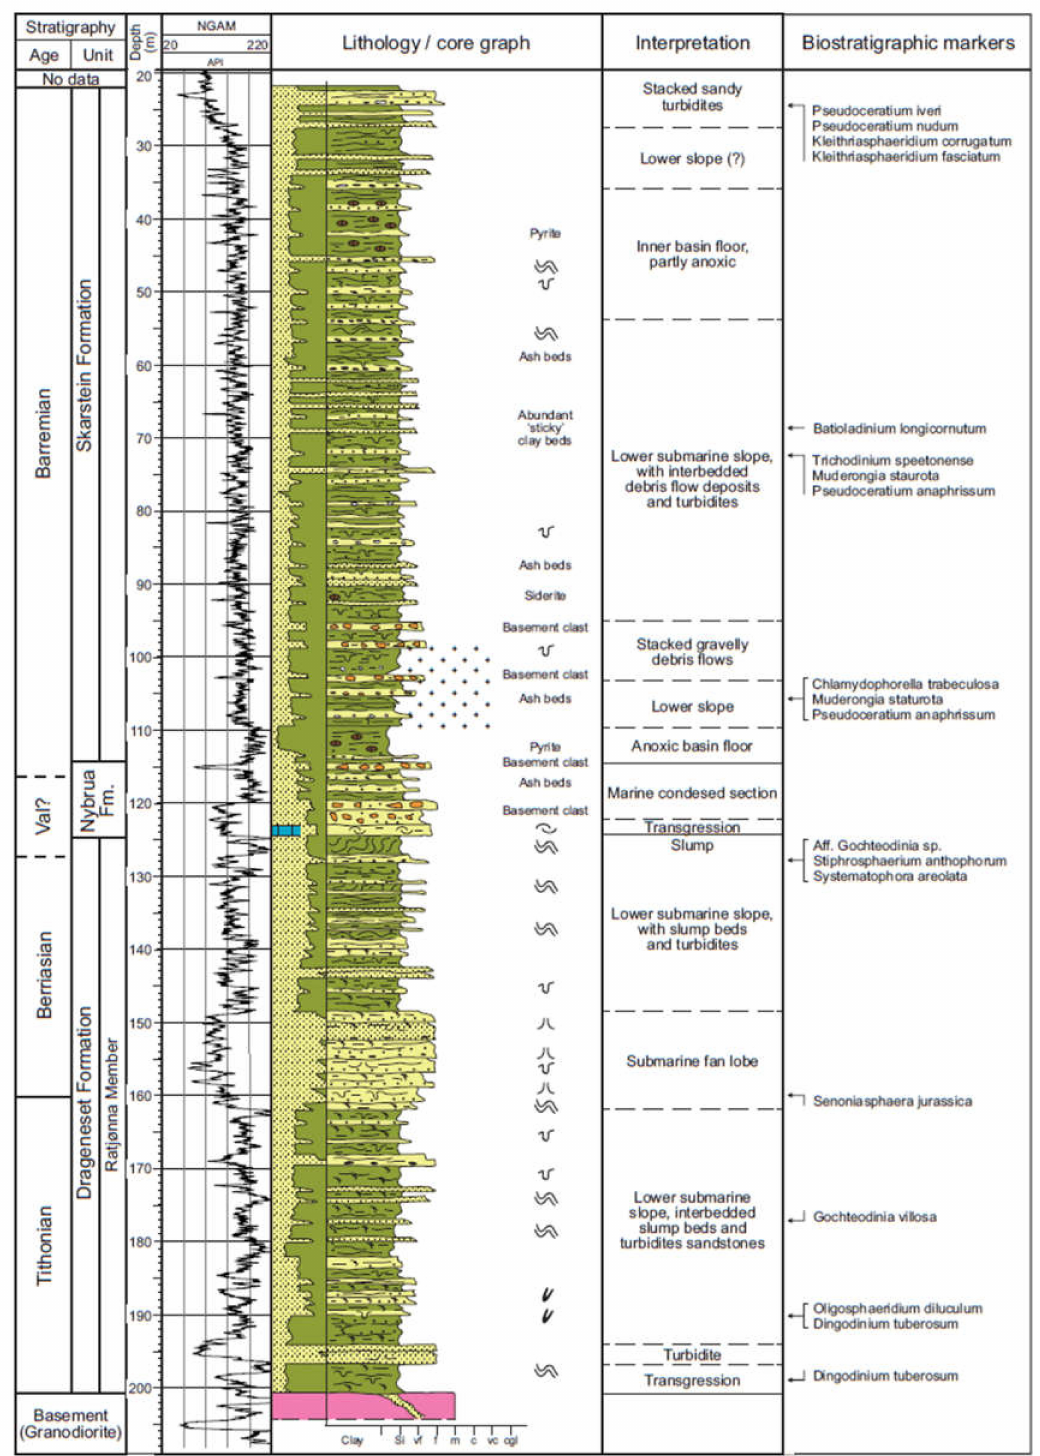
Figure 4. Lithological and gamma log of Bh 2, with interpretations of ages and depositional environments of the formations and members (Based on Bönner et al.